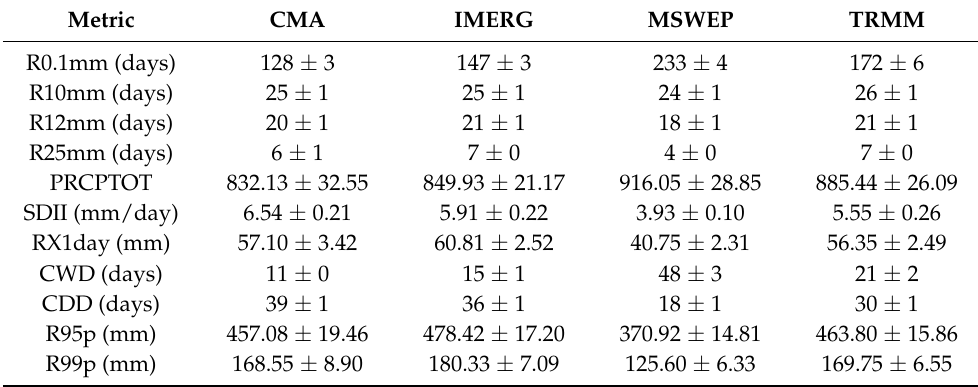
Table 4. Comparison of extreme precipitation indices for the observed data and the three